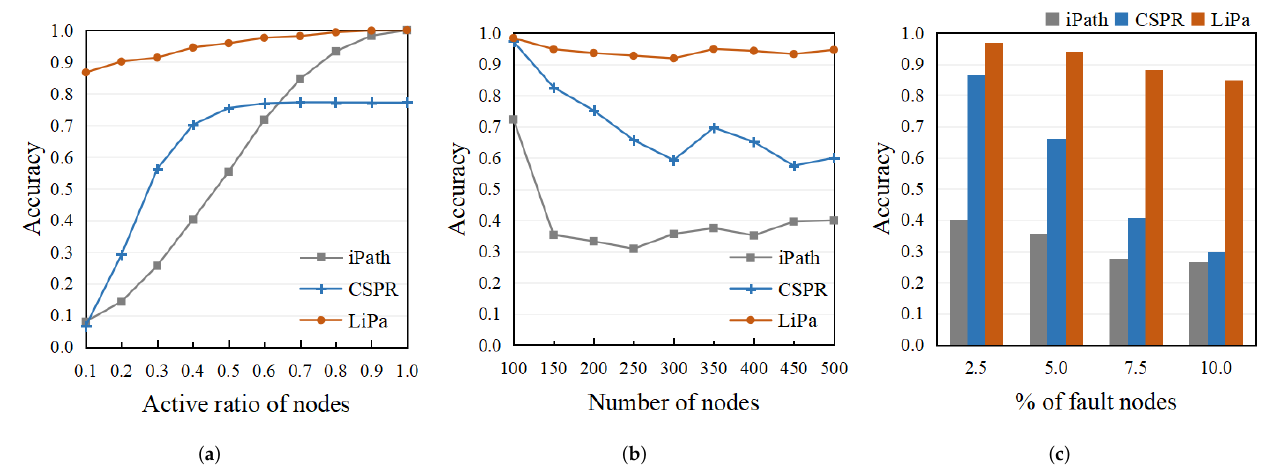
Figure 7. Comparison of the Accuracy : ( a ) Variation in accuracy rate with different node activity; ( b ) Variation in accuracy rate with the number of nodes; ( c ) Variation in accuracy rate with the different node failure